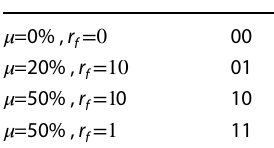
Table 1 The label corresponding to each faulty operating condition